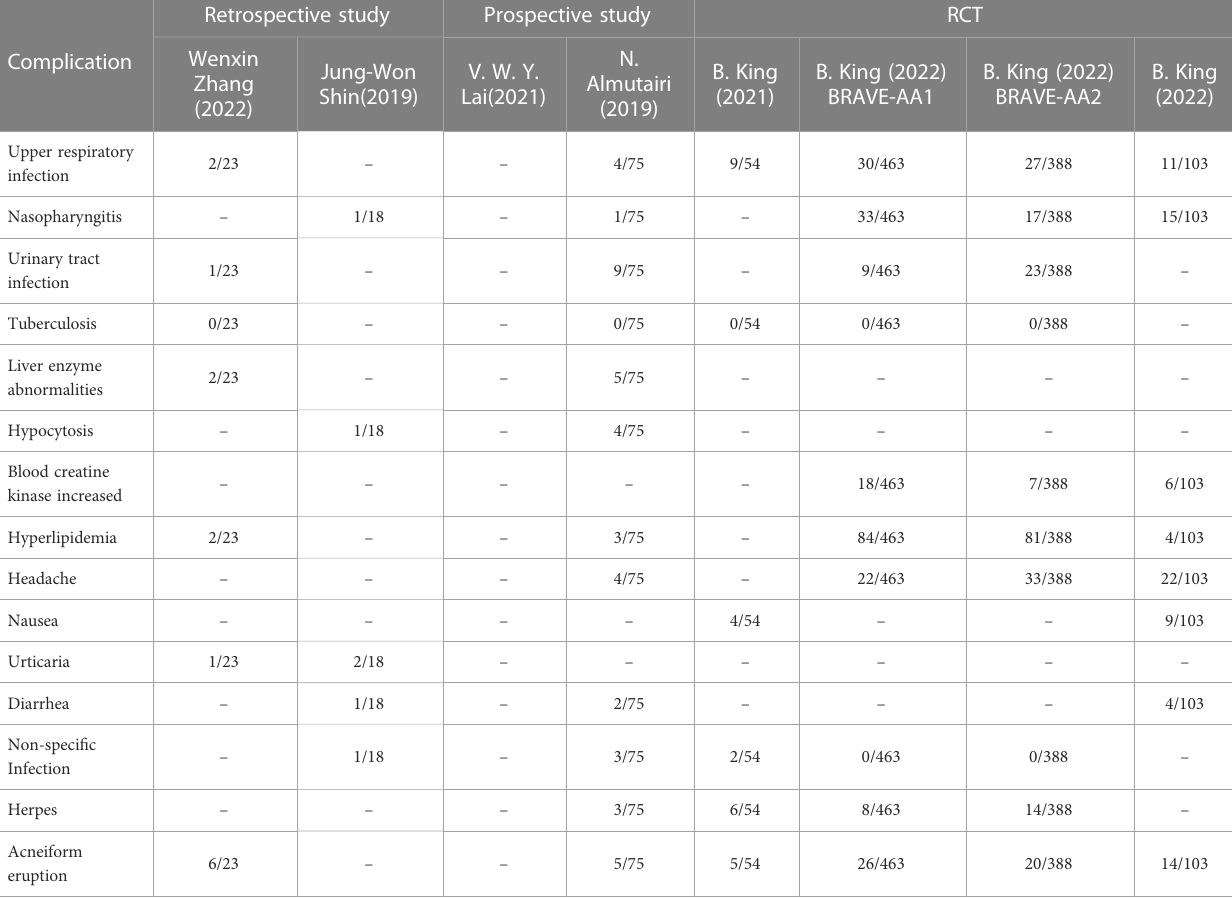
TABLE 3 Summary of adverse events.